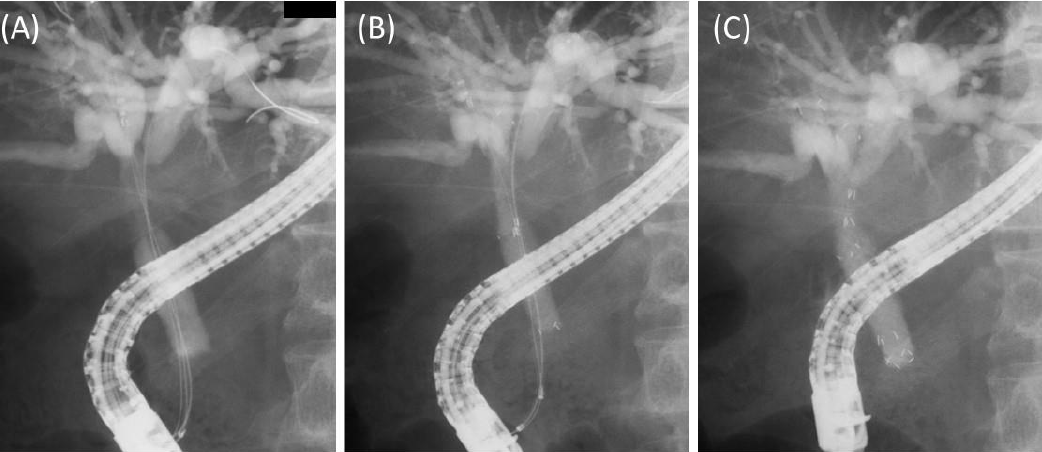
Figure 3. Deployment of three 8 mm FCSEMSs. ( A ) After placing three guidewires in the right anterior, right posterior, and left lateral branches, one introducer was inserted into the right posterior branch. ( B ) Following stent placement in the right posterior branch above the papilla, two introducers were inserted though the side of the first stent. ( C ) Finally, three stents were placed above the papilla without blocking the side branches.